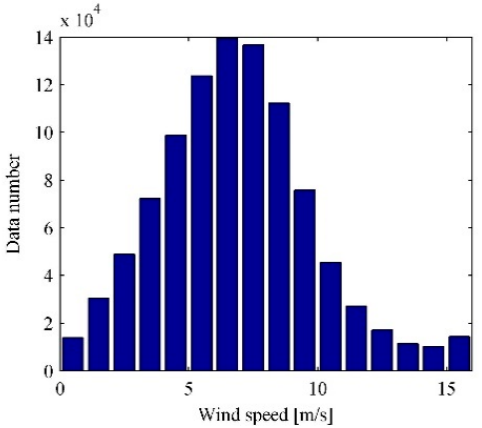
Figure 9. Amount of data for the 16 data subsets.